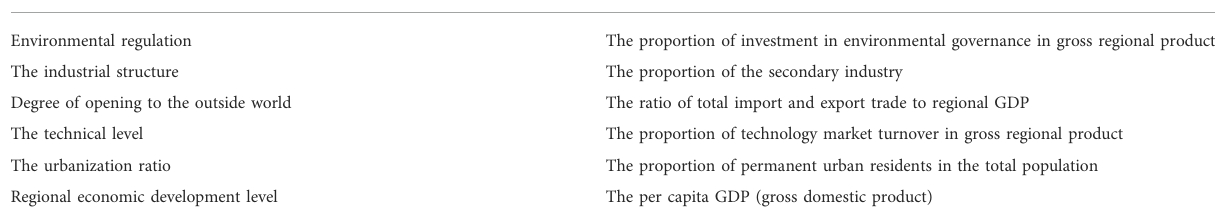
TABLE 2 Environment variables and